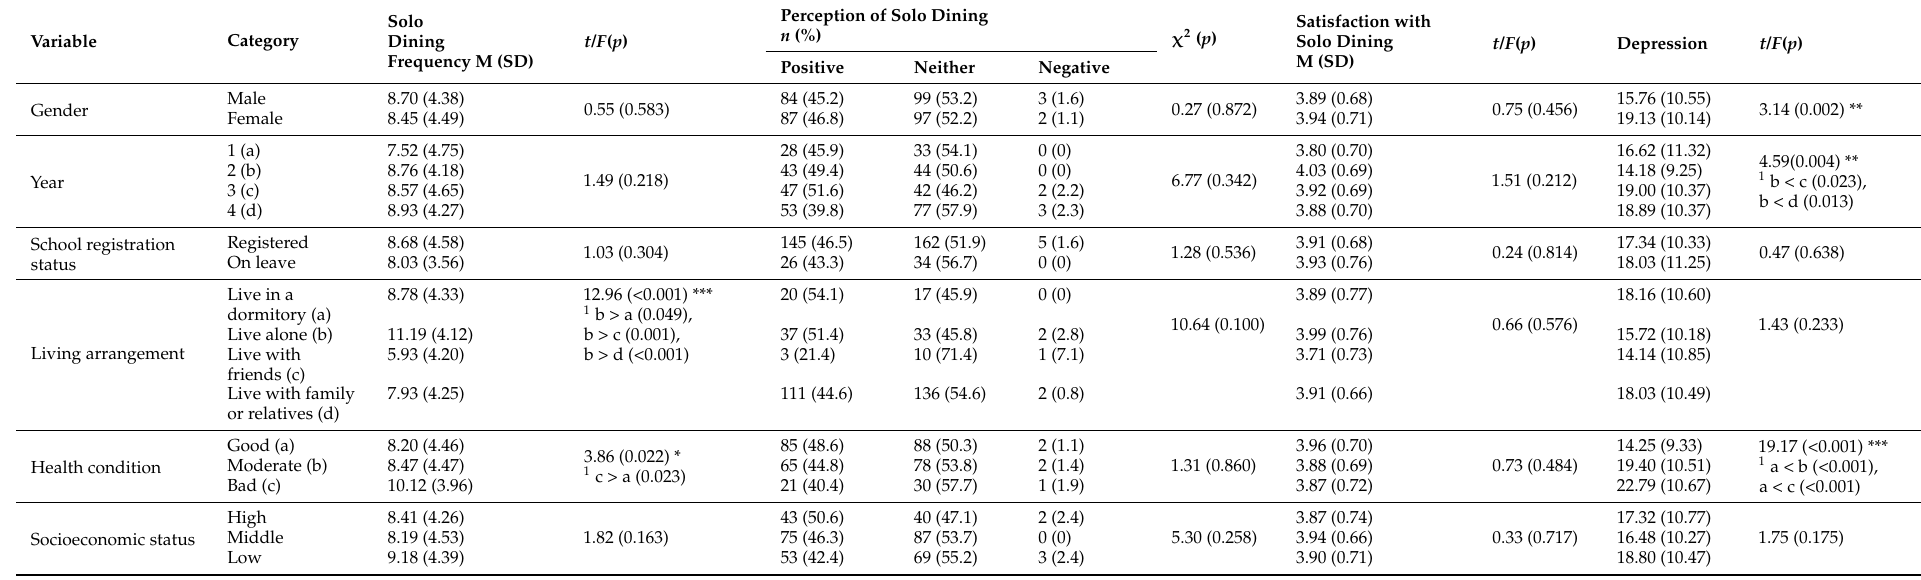
Table 2. Association between solo dining-related characteristics and the occurrence of depression according to participants’ general characteristics ( N = 372 ).